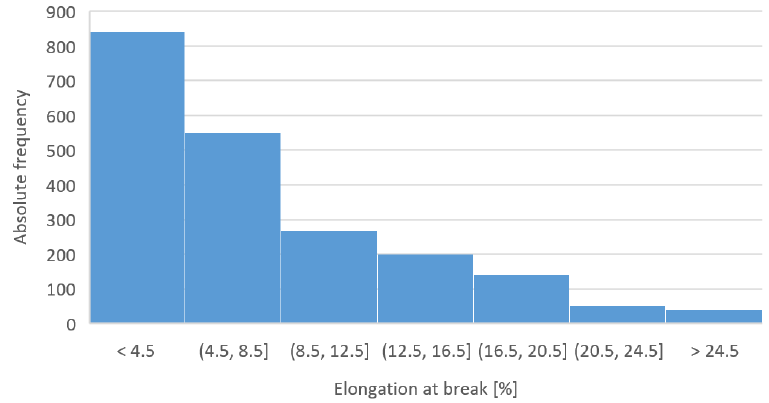
Figure 14. Elongation at break histogram of the input